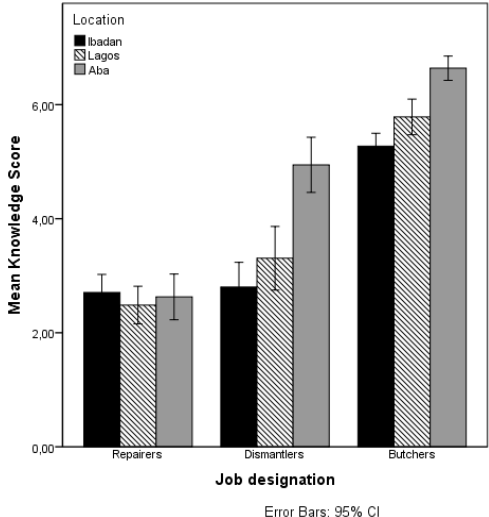
Figure 3. Mean knowledge score by job designation and location.